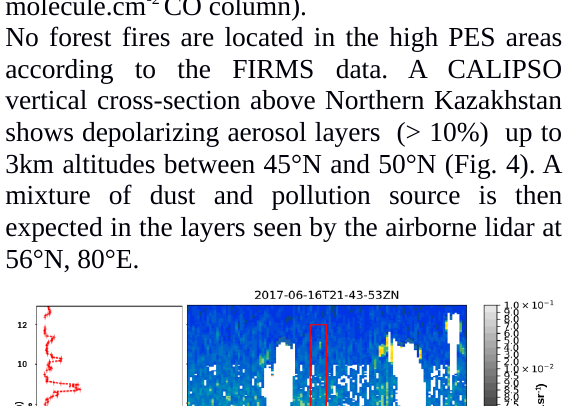
distribution 550